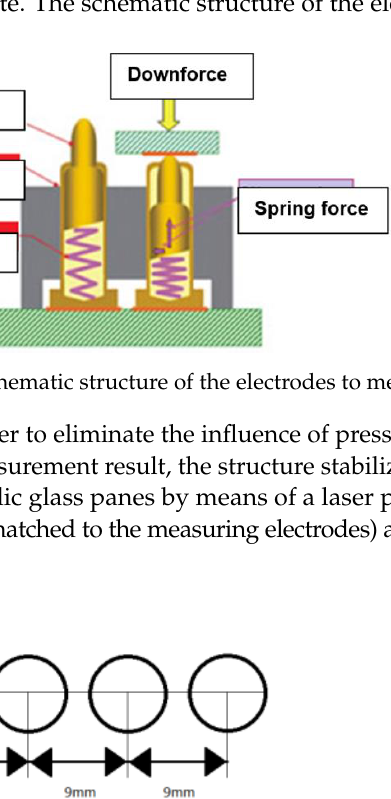
Figure 2. The equivalent circuit of electrical connections in the method used for measuring the surface resistance of textiles.